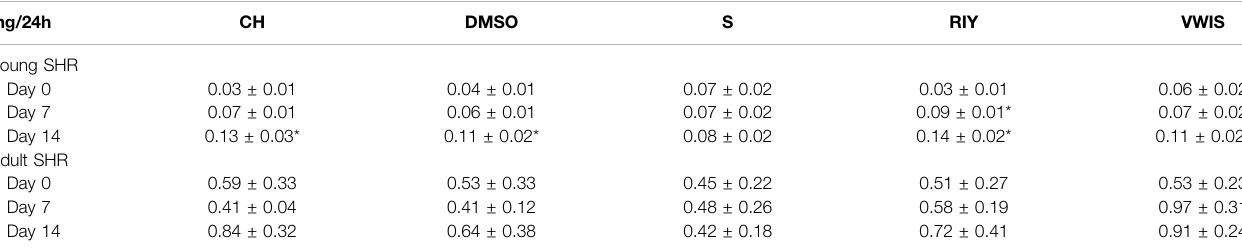
TABLE 1 | Urinary albumin excretion (UAE) measured on 0, 7th and 14th in young and adult spontaneously hypertensive rats (SHR) receiving intravenous